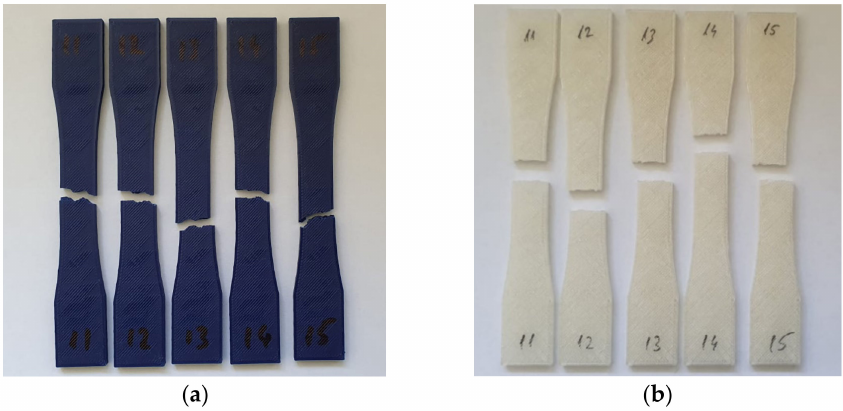
Figure 4. Fracture modes of tested parts: ( a ) Fractured PLA parts exposed to UV-C; ( b ) PETG parts exposed to UV-C.